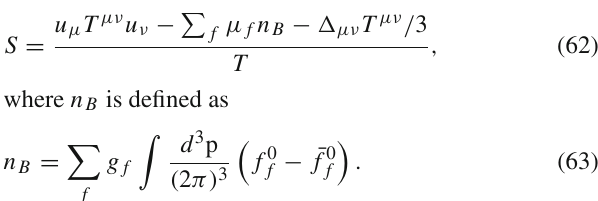
tial (Fig. 6b). The range of Re is found to be 5.49–11.86 in